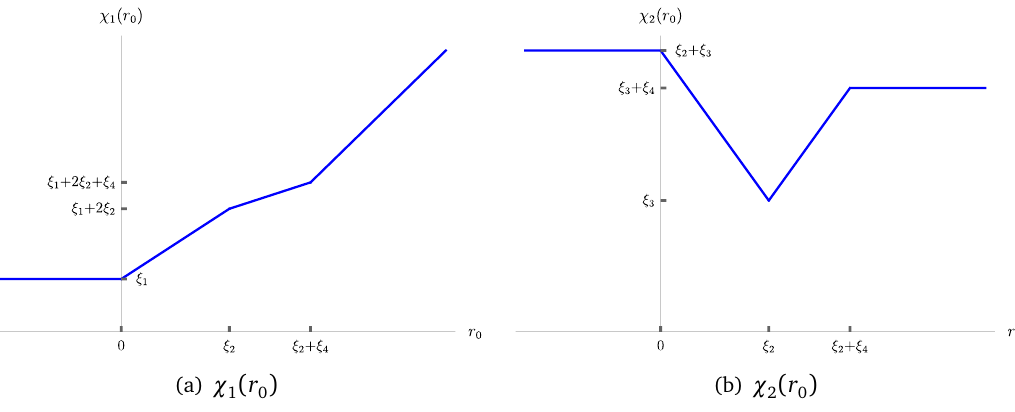
Figure 30: The E